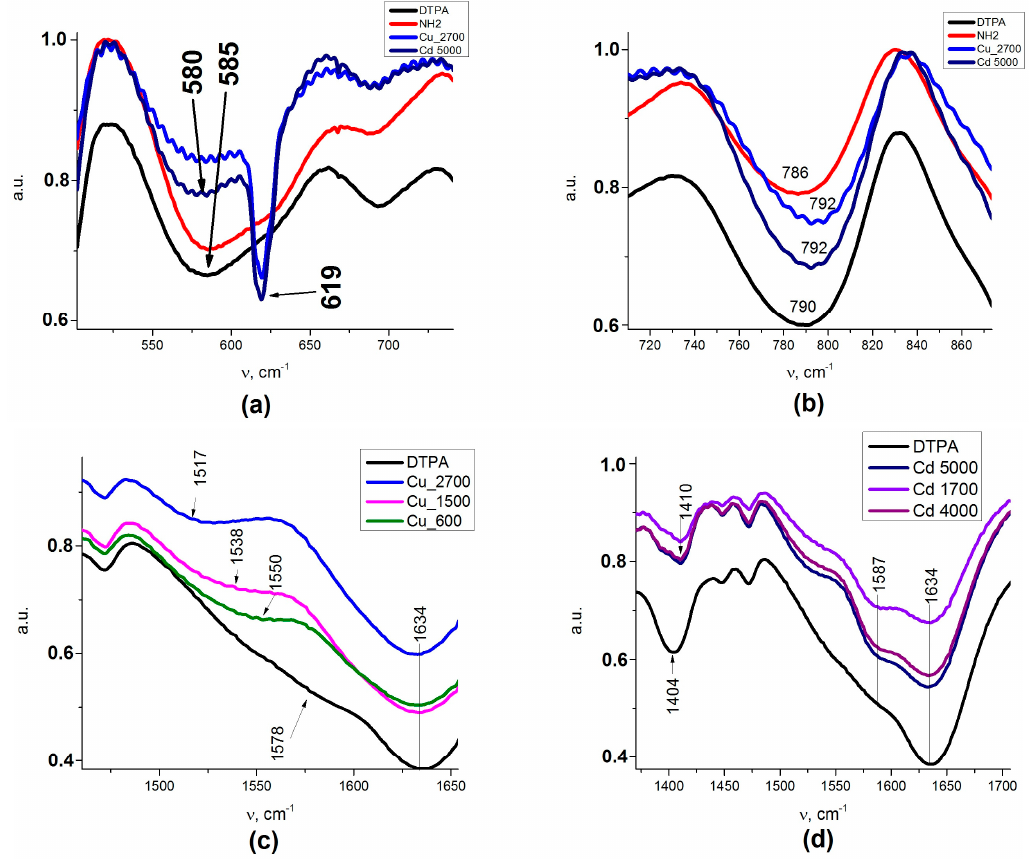
Figure A1. FTIR of the Fe 3 O 4 / SiO 2 -NH 2 - DTPA-Cu/Cd nanocomposites: ( a ) 500-700 cm − 1 (Me–O bond vibrations region); ( b ) 740-820 cm − 1 (C–C bond vibrations region); ( c ) 1500-1650 cm − 1 ( ν C=O vibrations region); ( d ) 1400-1700 (COOH vibrations region).